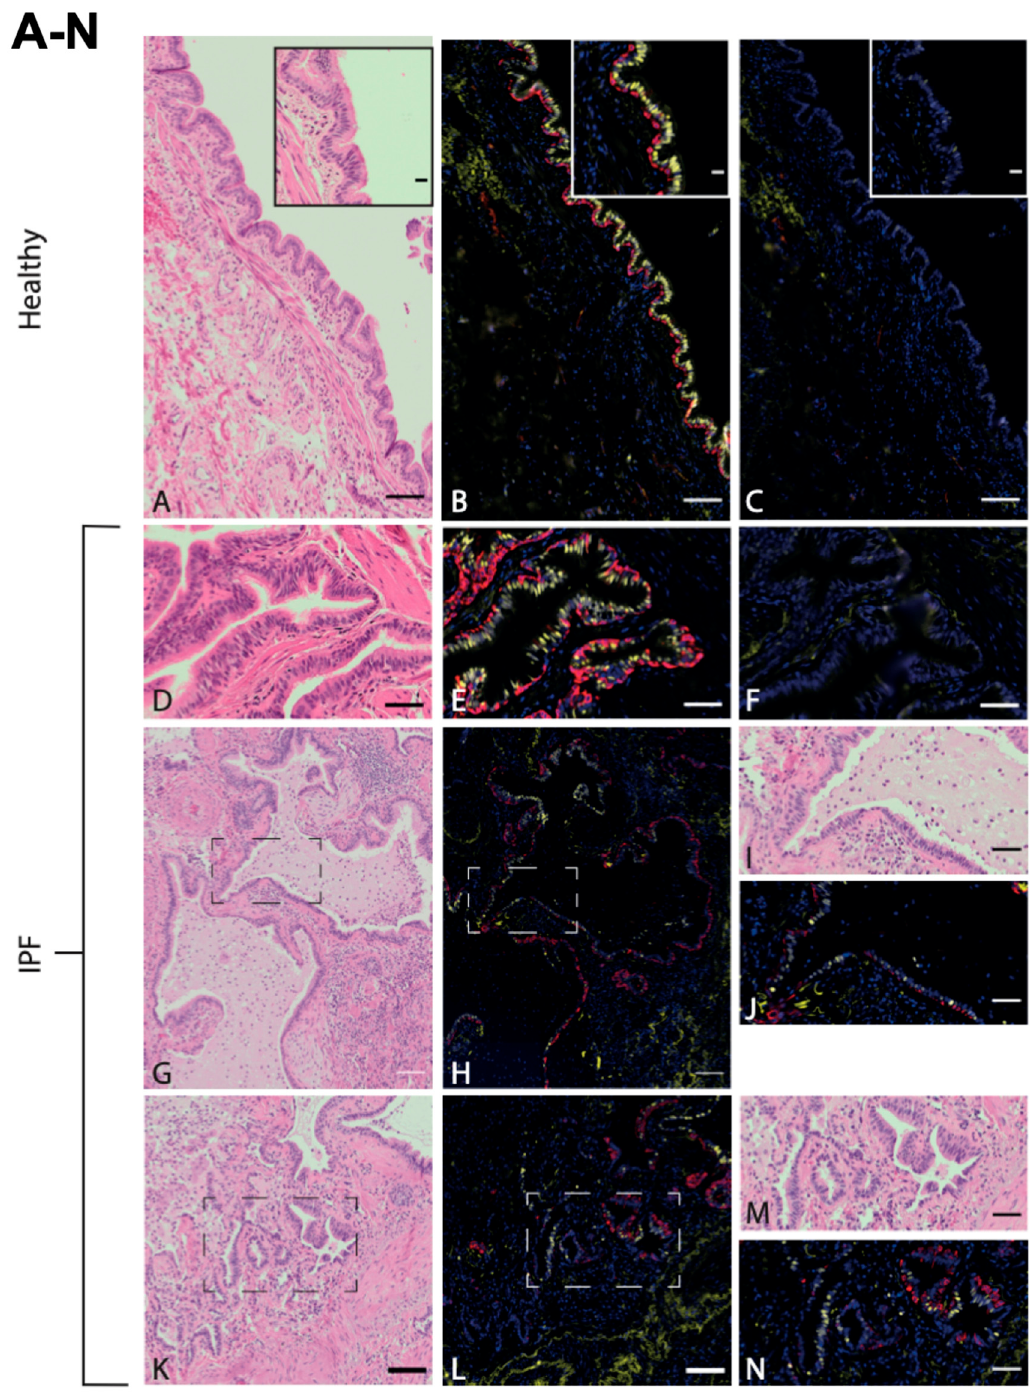
Figure 1. Ciliated airway epithelium in distal lung tissue in healthy and IPF. Antibody labeling of basal cells (KRT5, red) and ciliated cells (FOXJ1, yellow) in airway epithelium of distal lung tissue derived from healthy individuals (( A – C ), enclosed within an enlarged area of ciliated epithelium of terminal bronchiole), and IPF patients ( D – F ), all with corresponding H&E stains ( A , D ) and negative controls ( C , F ). Honeycomb cysts, positive for FOXJ1 and KRT5 in IPF ( G , H ), with enlarged visualization of marked area ( I , J ). Pulmonary region of suspected bronchiolization ( K , L ) with enlarged visualization of marked area ( M , N ). Images are representative of examined lung tissue samples (IPF n = 4 individuals, healthy n = 3). Scale bar: 100 µm ( A – C , G , H , K , L ), 50 µm ( D – F , I , J , M , N ), 20 µm (enlargement in ( A – C )).